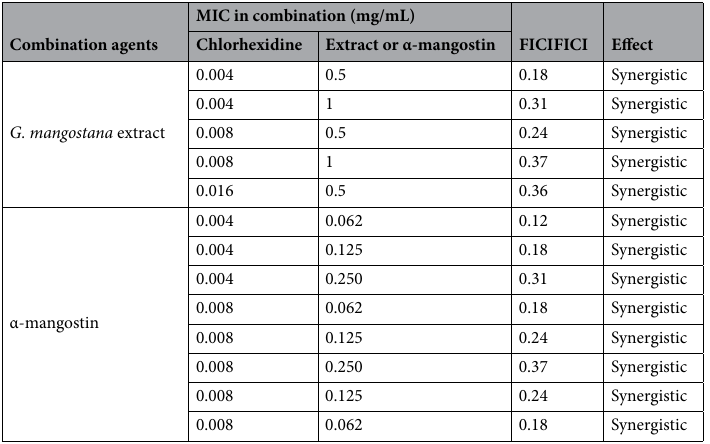
Table 3. Fractional inhibitory concentration index (FICI) of the combination test in targeting A. triangularis cysts.